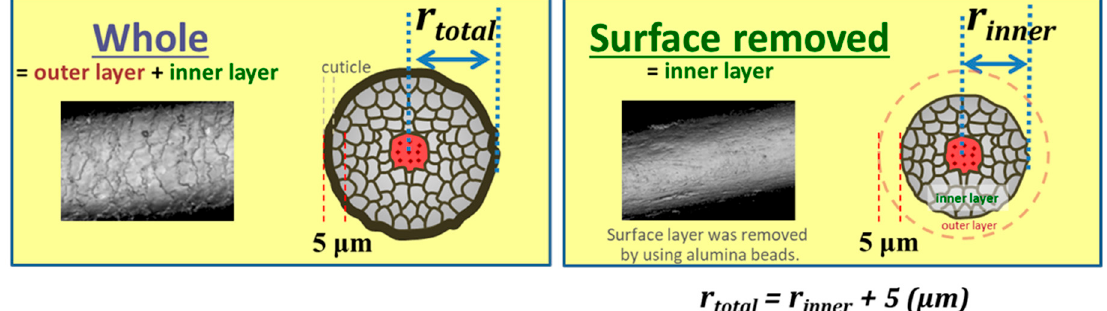
Figure 1. Surface layer was removed by using alumina beads. r total = radius of whole hair, r inner = radius of surface removed hair.